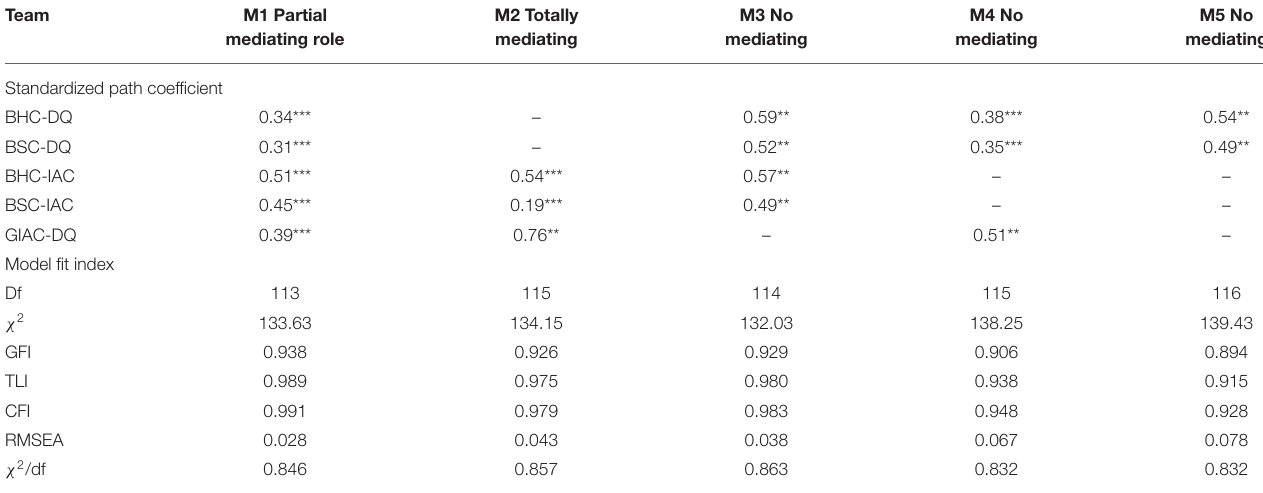
TABLE 4 | Nested comparison results of